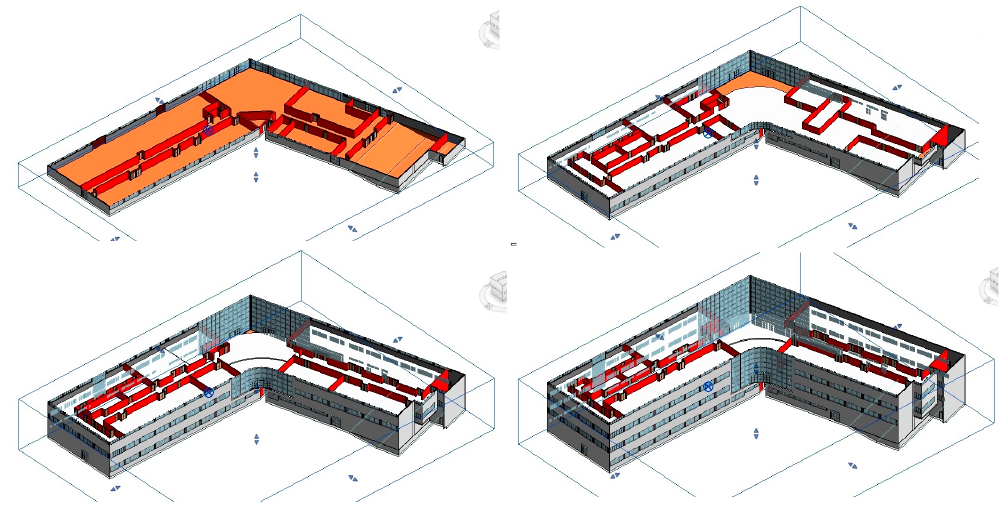
Figure 4. Rooms for each floor of the building limited by interior partitions.